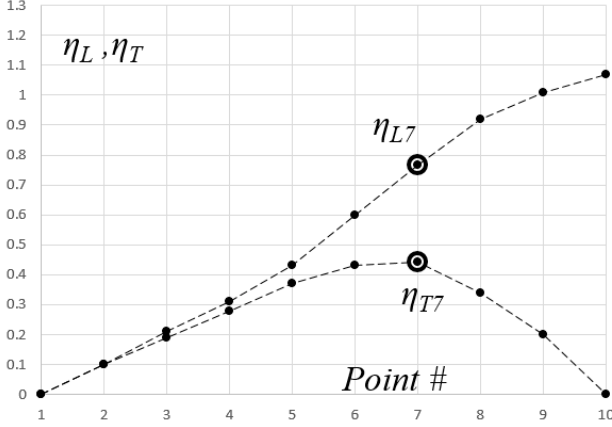
Figure 13. Hypothetical lift-thrust of flapping wings divergence along their evolution towards sustained flight.